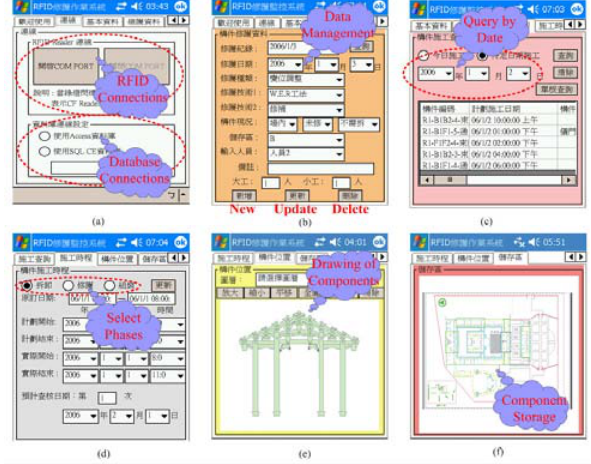
Fig. 11. Options: linkages (a); data management (b); ins-